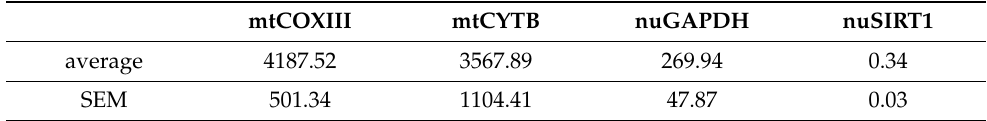
Figure 1. Serum of lung adenocarcinoma subjects have a high amount of ccf-DNA. The amount of mtDNA ( A ) and nuDNA ( B ) were quantified with qPCR using mtCOXIII and nuACTB primers, respectively, in serum of healthy volunteers ( n = 20), subjects with benign tumors ( n = 20) and with lung adenocarcinoma ( n = 57). The amount of mtDNA ( C ) and nuDNA ( D ) were quantified with qPCR using mtCOXIII and nuACTB primers, respectively, in serum of subject with stage I ( n = 21), stage II ( n = 12), stage III ( n = 13) and stage IV ( n = 11) of lung adenocarcinoma. The serum was obtained from LCBRN. The amount of DNA is expressed as pg of DNA in 100 µ L of serum. ** p < 0.01, *** p < 0.001, **** p < 0.0001. Table 2. DNA in serum of subjects with lung adenocarcinoma (pg/100 µ